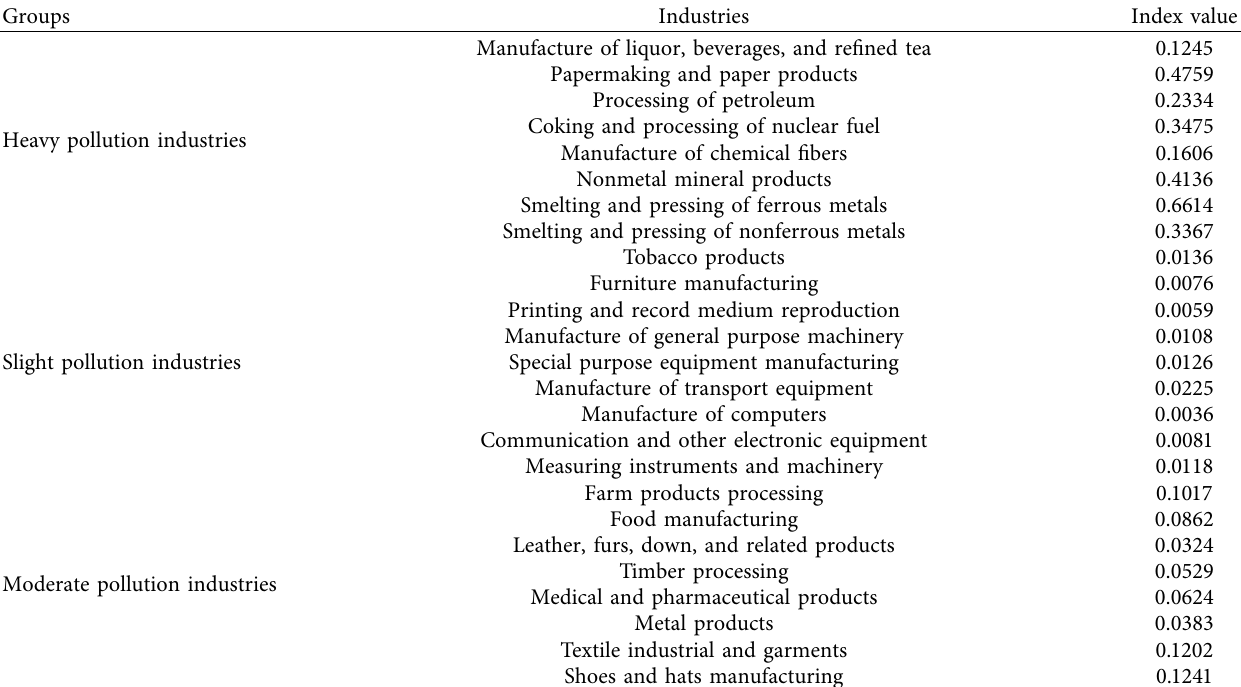
Figure 2: Changes in the average pollution intensity of the three pollution industries. Table 2: Pollutant emission intensity values of various